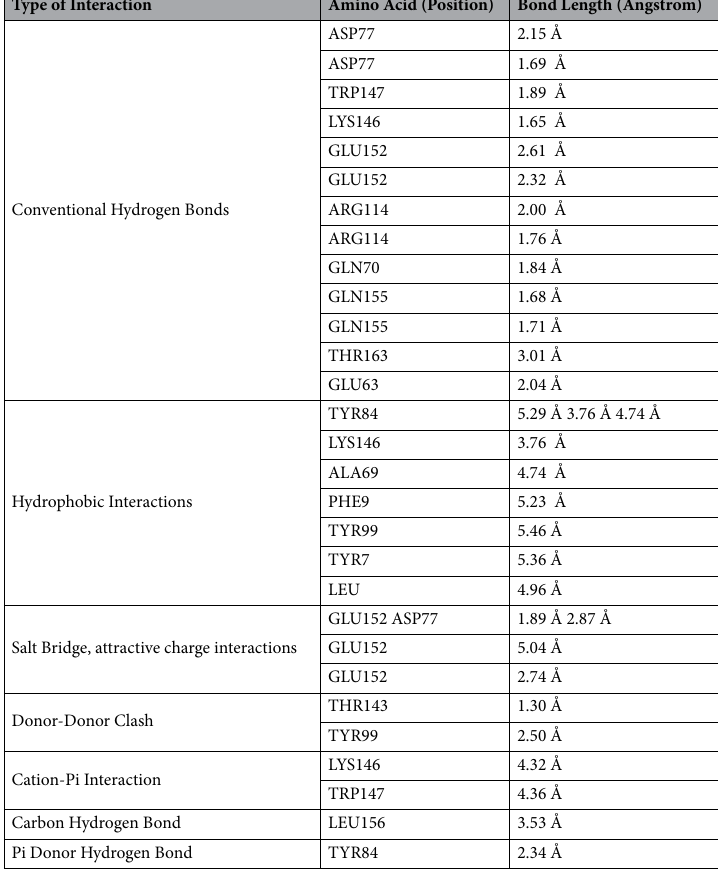
Table 5. The interactions involved docking the epitope HLGYKCSIRK with its corresponding MHC